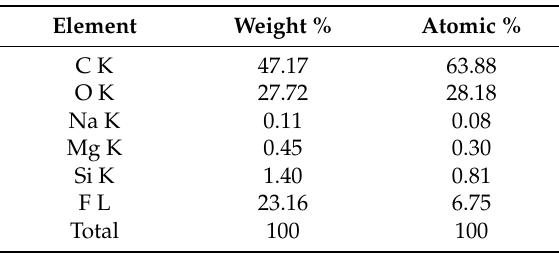
Figure 5. Histogram of SEM images of genuine and counterfeit banknotes. Table 2. Flag XRD of genuine banknote.